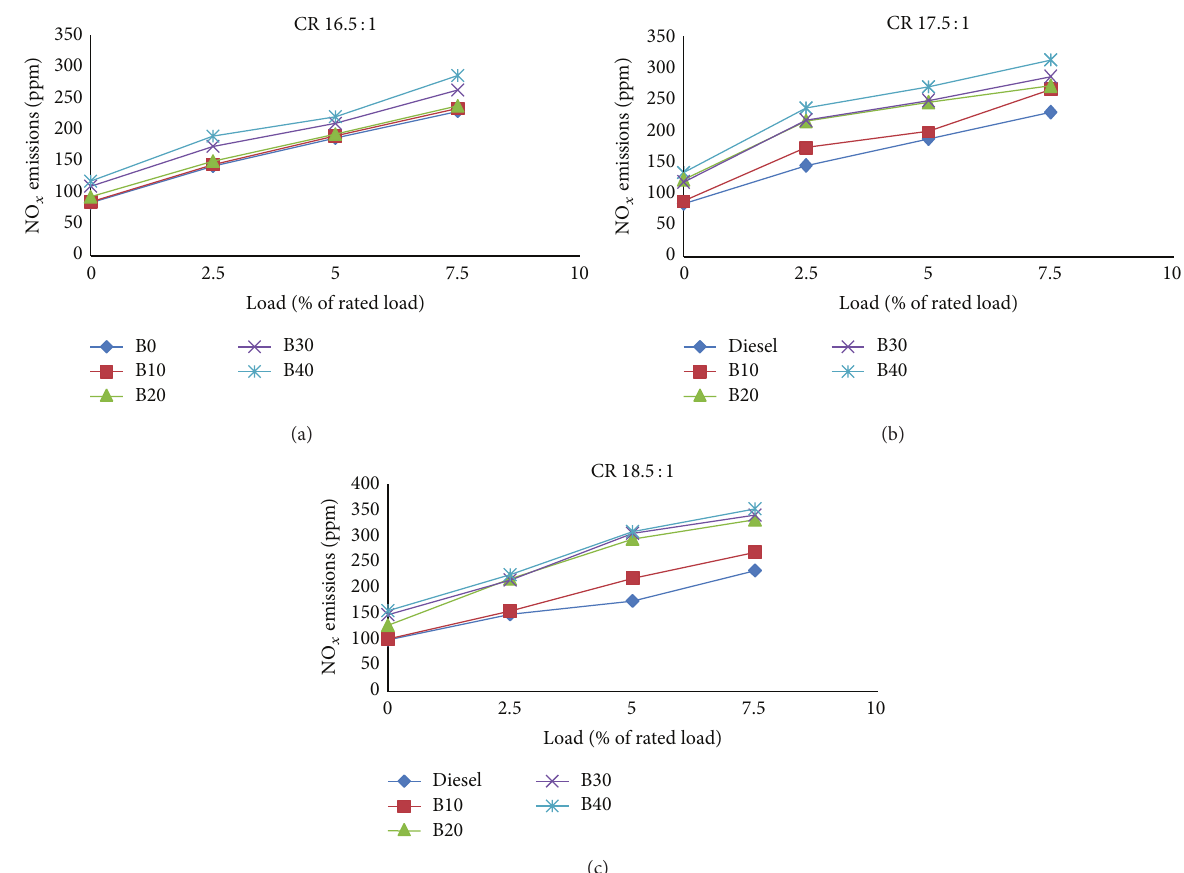
Figure 9: Variation of NO 𝑥 emission with engine load for diesel and all blends of Jatropha ethyl ester at different compression ratios.